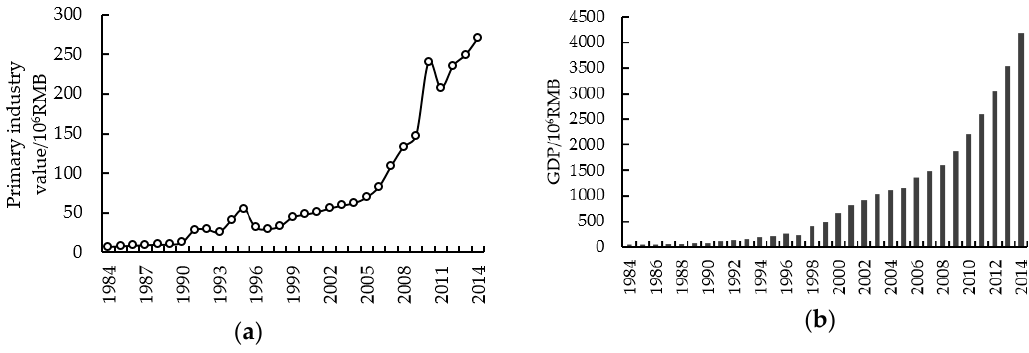
Figure 11. Primary industry ( a ); and gross domestic product (GDP) ( b ) of study area (source: [22]).